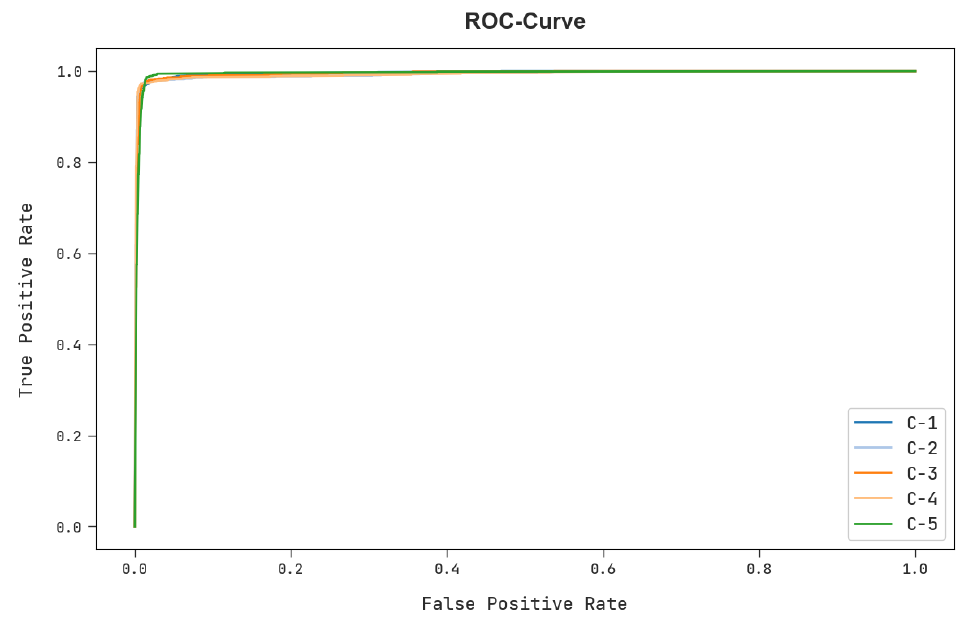
Figure 8. ROC curve analysis of AOEDBC-DL system.